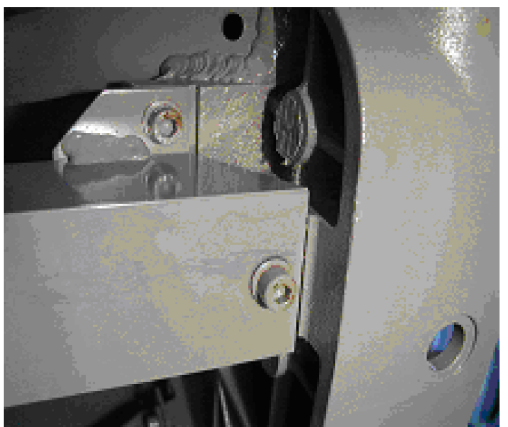
Figure 3. A car bracing analysis.